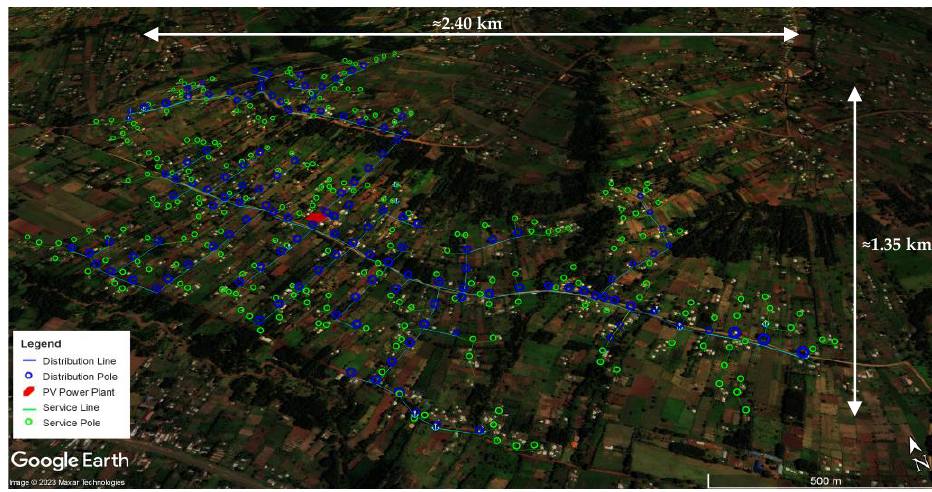
Figure 15 . A map representation of the distribution network of the modelled mini-grid. Figure 15. A map representation of the distribution network of the modelled